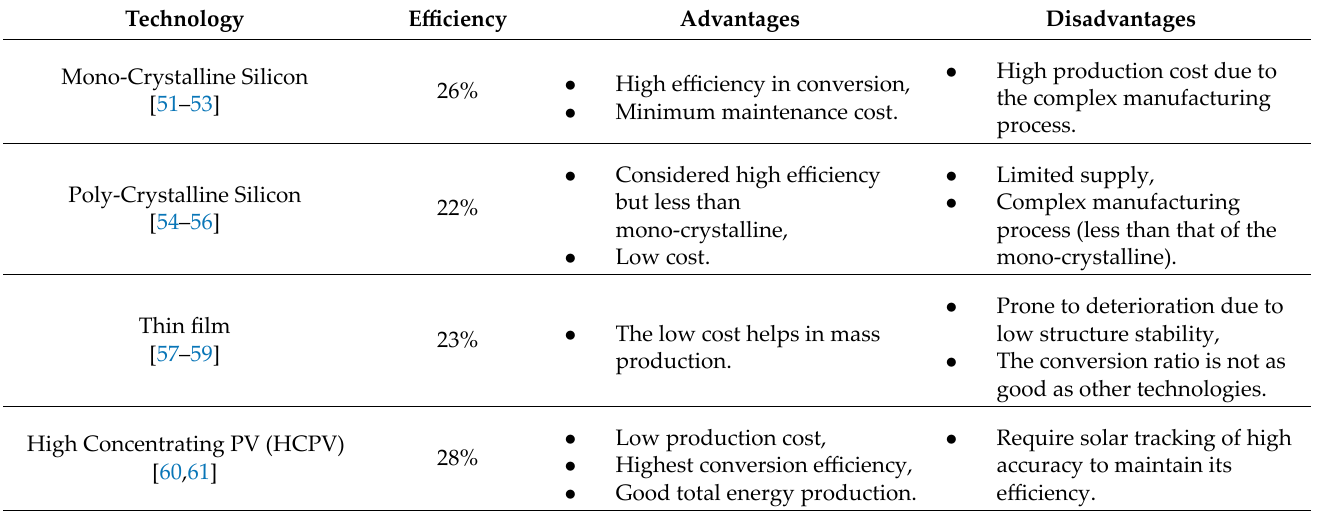
Table 2. Comparison between PV technologies.